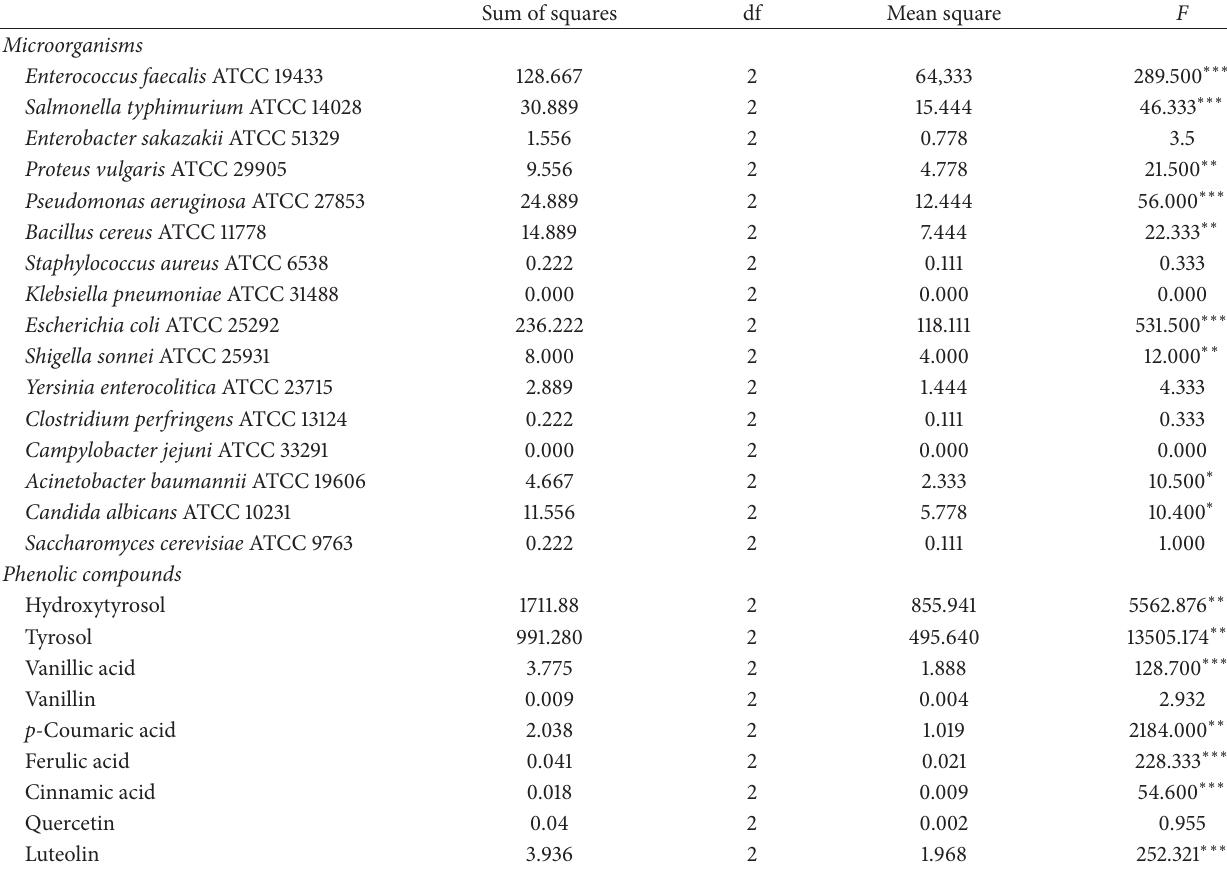
Table 6: ANOVA results of antimicrobial activity of phenolic extracts of virgin olive oils and phenolic compounds. Sum of squares df Mean